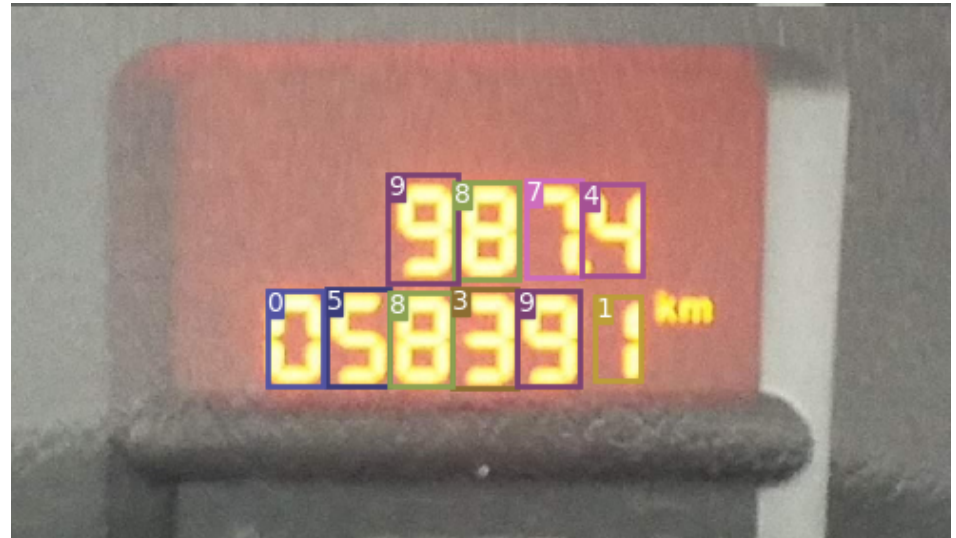
Figure 2. Example of character recognition in a car